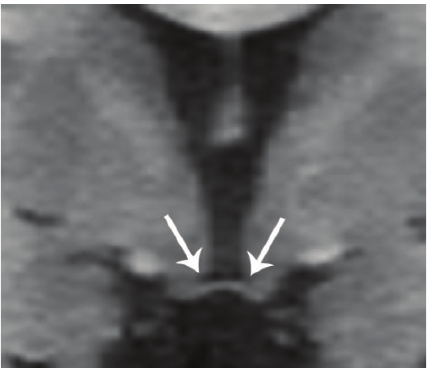
Figure 3: Reformatted coronal SPGR T1WI (repetition time msec/echo time msec/inversion time msec, 11/5/500) demonstrating small, broad based diverticula involving the tuber cinereum that contain hypointense 3rd ventricular cerebrospinal fluid (arrows). The 3rd ventricular floor is enlarged in the transverse